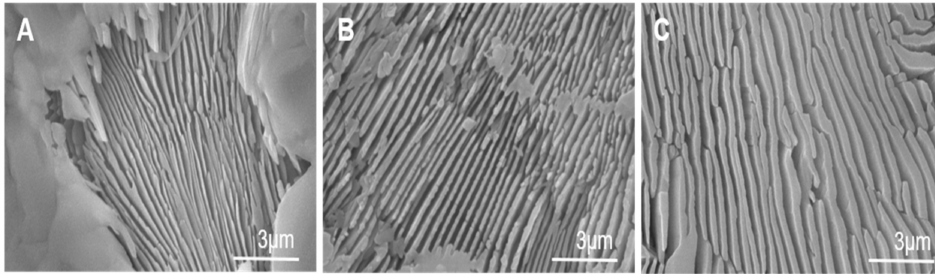
Figure 3. SEM micrographs of scaffold surfaces after chemical etching with acetic acid for a cooling rate of: ( A ) 50 ◦ C/h ( B ) 16.5 ◦ C/h and ( C ) 5.5 ◦ C/h.